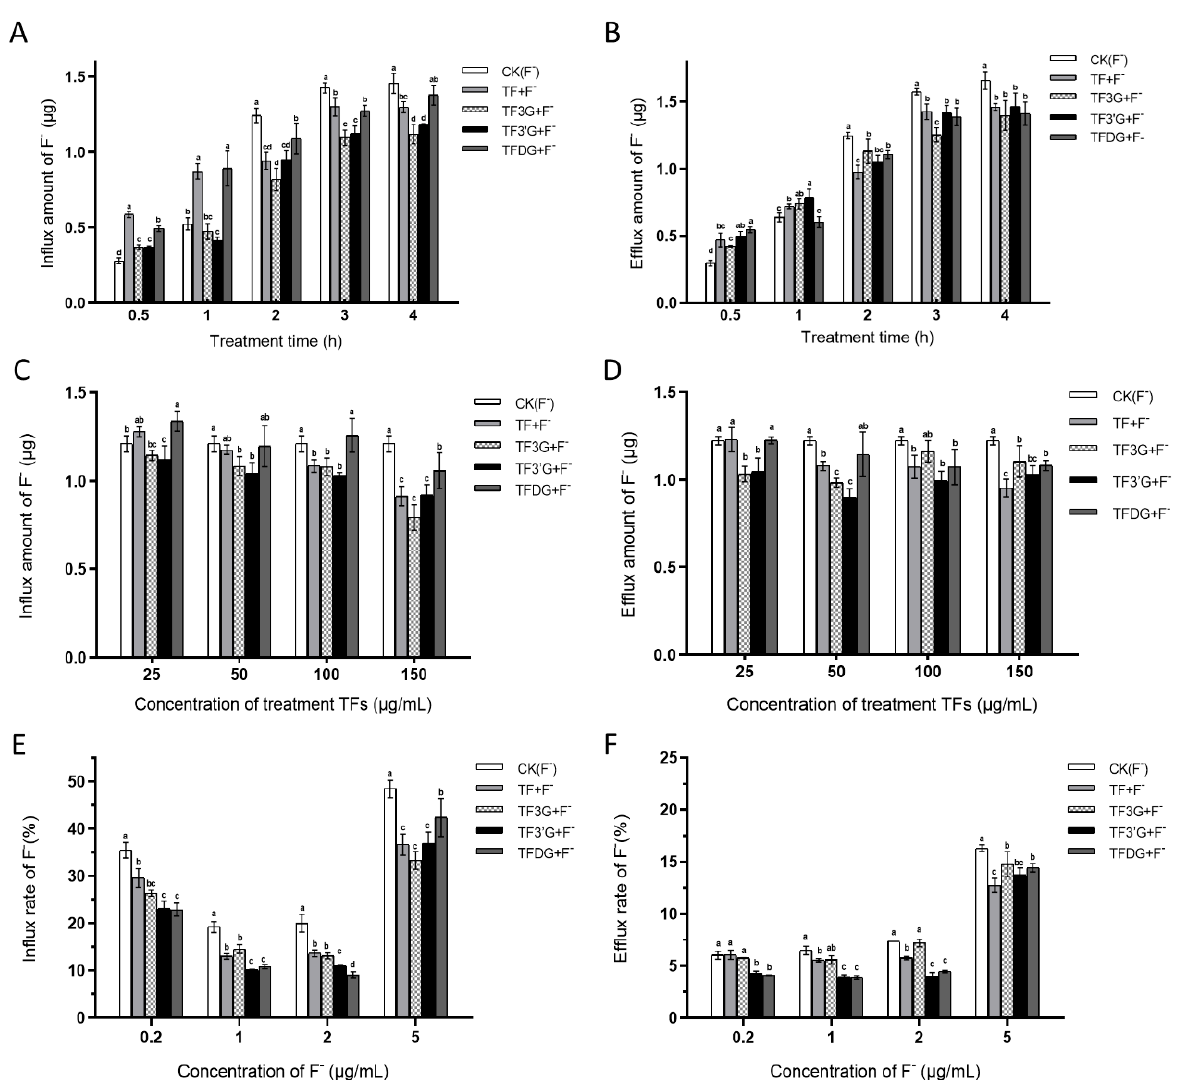
Figure 3. ( A , B ) Effect of TFs on F − transport amount in Caco-2 cells under different treatment time. ( C , D ) Effects of different concentrations of TFs on F − transport amount in Caco-2 cells. ( E , F ) Transport rate of F − in Caco-2 cells under different F − concentrations. ( A , C , E ) influx transport (AP-BL); ( B , D , F ) efflux transport (BL-AP). Different lowercase letters in the same group indicate significant differences at p <